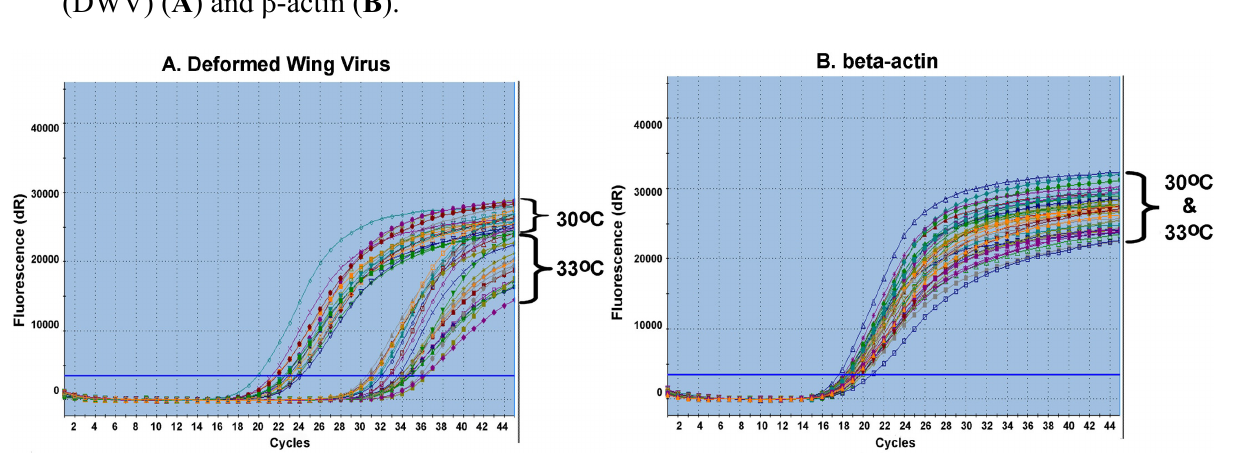
Figure 2. The representative qRT-PCR amplification plots of Deformed Wing Virus (DWV) ( A ) and β -actin ( B